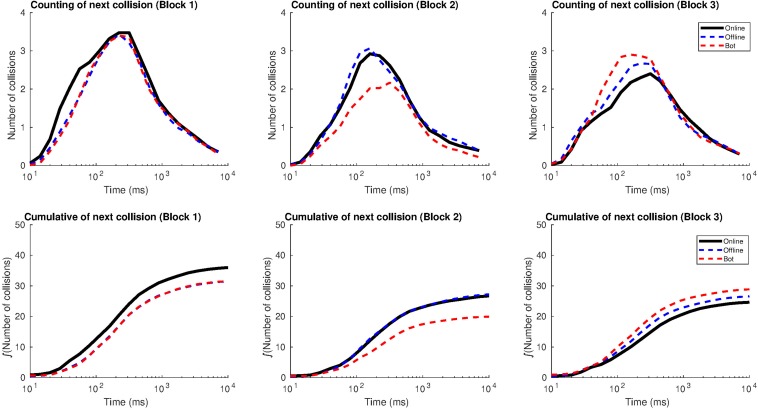
Distribution of the number of crossings according to the window span in Study 1. The distribution has a Gaussian shape. The x-axis (time) is shown on a logarithmic scale in order to see the relation between short times (milliseconds) and longer ones (dozens of seconds, which is the length of a round). On the top: number of crossings after one crossing of reference in relation to the time they are produced, for each block and type of agent. On the bottom: number of accumulated crossings as a function of time.